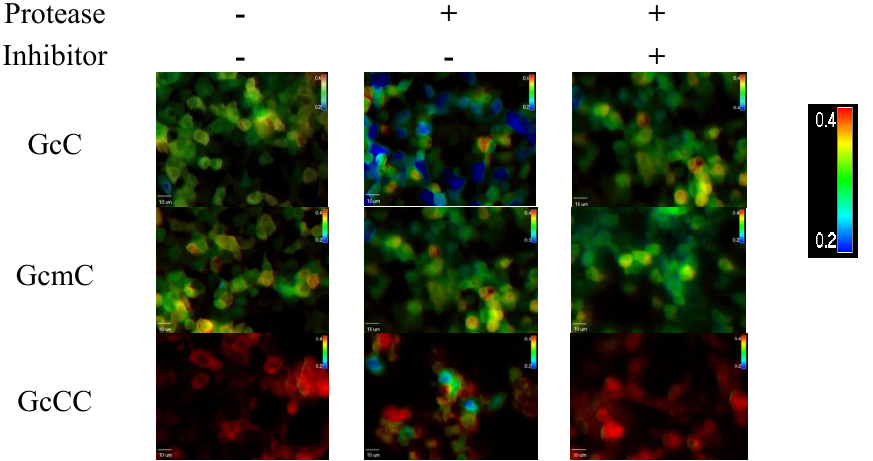
protease plasmid co-transfected cells in the absence of protease inhibitor displayed, reduced FRET signals at 50 h post transfection by showing mixture of blue, green, yellow, and red colored cells (Figure 4: GcCC with Protease+ and Inhibitor-) as compared to that signals produced from cells in the presence of protease inhibitor (Figure 4: GcCC with Protease+ and Inhibitor+). All of the cells displayed a red color if protease activity was inhibited by its inhibitor, indicating a FRET ratio of 0.4 (GcCC with Protease+ and Inhibitor+). The probe GcCC and protease co-transfected cells emitted sensitized red fluorescence when an inhibitor, ritonavir was added to the cell culture medium. The addition of the protease inhibitor to the cell culture medium prevented the cleavage of the peptide linker by the protease and thus retained the high FRET signal. As a control, the mutated probe has no response to either the presence or absence of the protease, and neither does it respond to the protease inhibitor, suggesting that the molecular probe designed in this study is specific to HIV-1 protease activity and inhibition. Figure 4. Visualization of HIV-1 protease activity and inhibition in vivo. 293T cells were either transfected with different structured probes alone or co-transfected with the probe and HIV-1 protease expression plasmids. FRET imaging microscopy measurement was performed at 50 h post transfection. Ritonavir, an HIV-1 protease inhibitor, was added to the cell culture medium to prevent the cleavage of the probe protein. The color bar indicates FRET